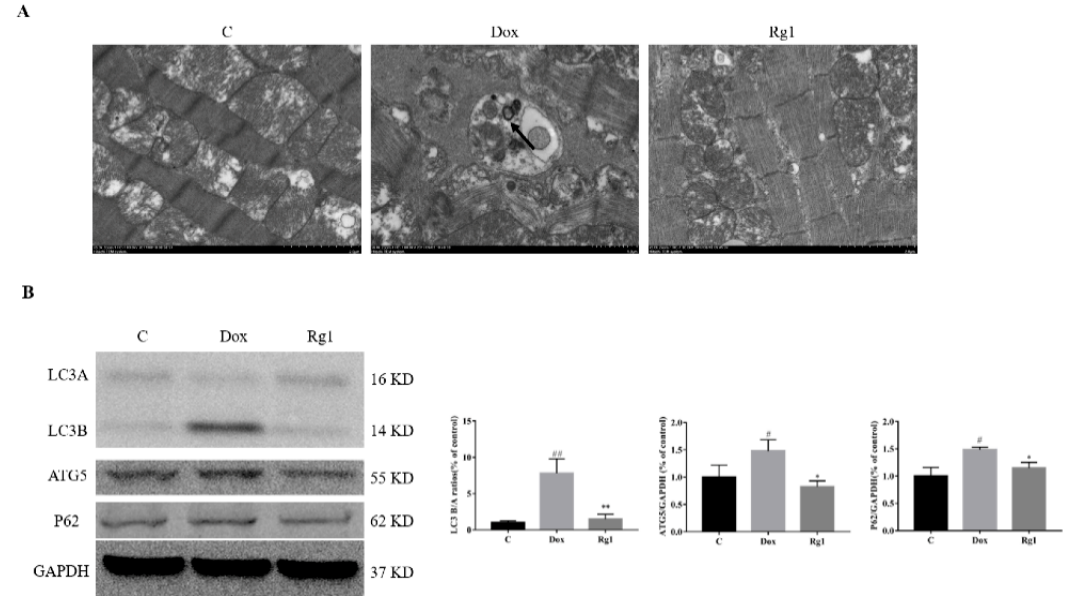
Figure 3. Rg1 inhibits autophagy in the hearts of mice. ( A ) Electron microscope images of autophagosome (indicated by arrow, 50,000×) from three groups. ( B ) Expression of LC3, ATG5 and P62 protein in mouse heart. GAPDH was used as the loading control. # p < 0.05, ## p < 0.01 vs C group, * p < 0.05, ** p < 0.01 vs DOX group.